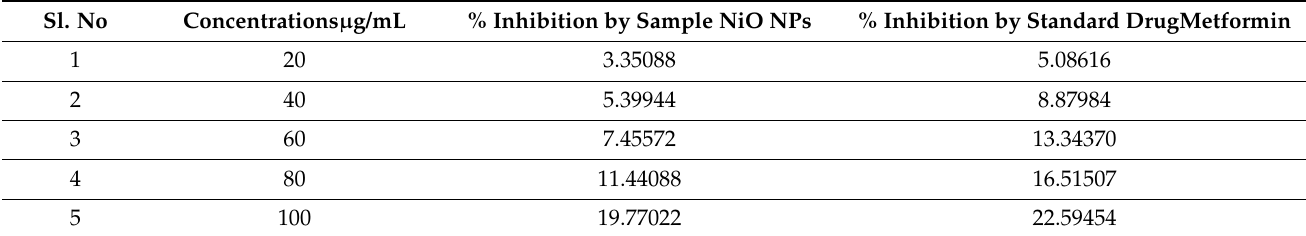
Table 1. Antidiabetic activity of NiO NPs by α -amylase (pancreatic) inhibition assay by DNS method. Sl. No Concentrations µ g/mL